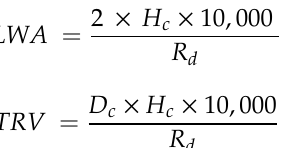
Figure 1. Side and top view of a citrus orchard, indicating where to take the different dimensions (row spacing R d , tree spacing T d , canopy height H c , diameter along the row D l , and diameter across the row D c ). Likewise, the LWA (m 2 ha − 1 ) and TRV (m 3 ha − 1 ) in the two plots were calculated using Equations (1) and (2), respectively.